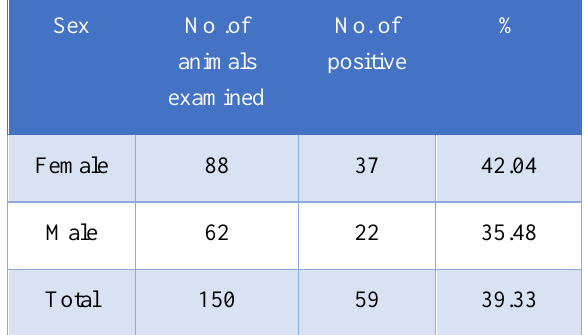
Table, 3: Infection rate of bovine theileriosis by